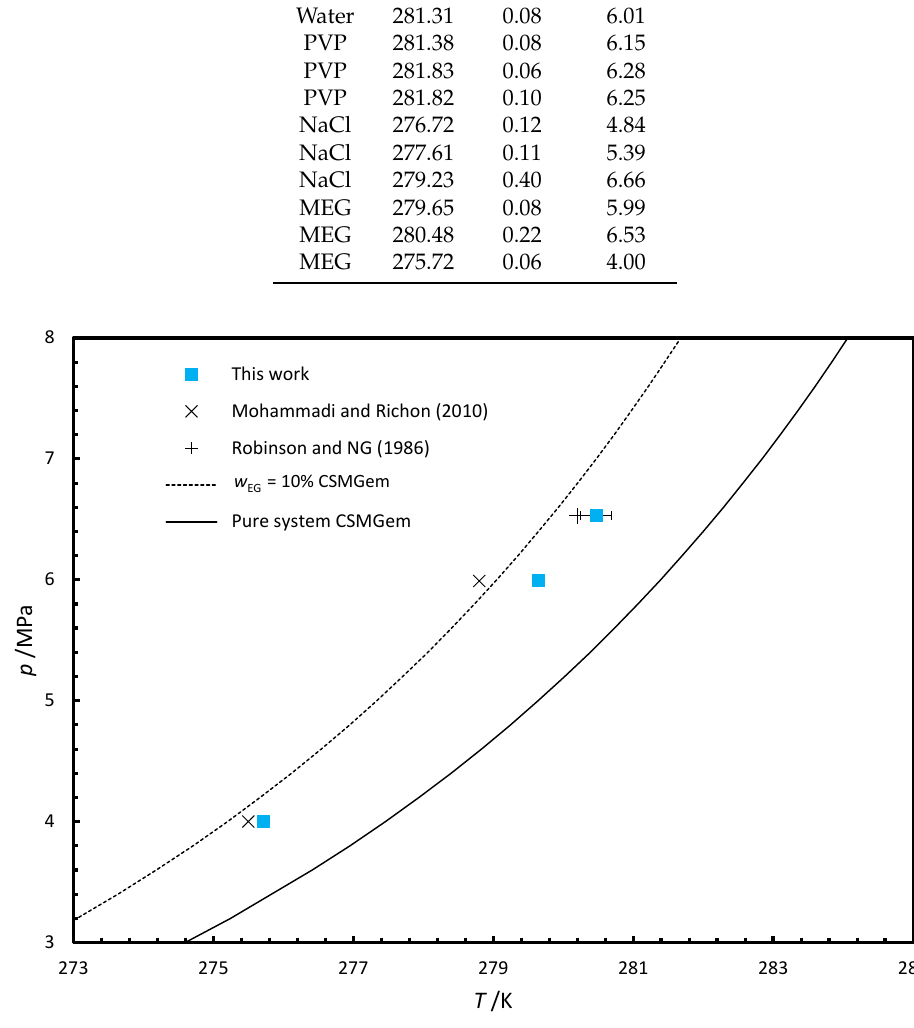
Figure 14. Hydrate-liquid-vapor equilibrium for the system water + MEG ( w MEG = 10%) + CH 4 . Error bars correspond to standard uncertainty. Literature data are also shown [52,53]. The curves show phase equilibria predictions using CSMGem